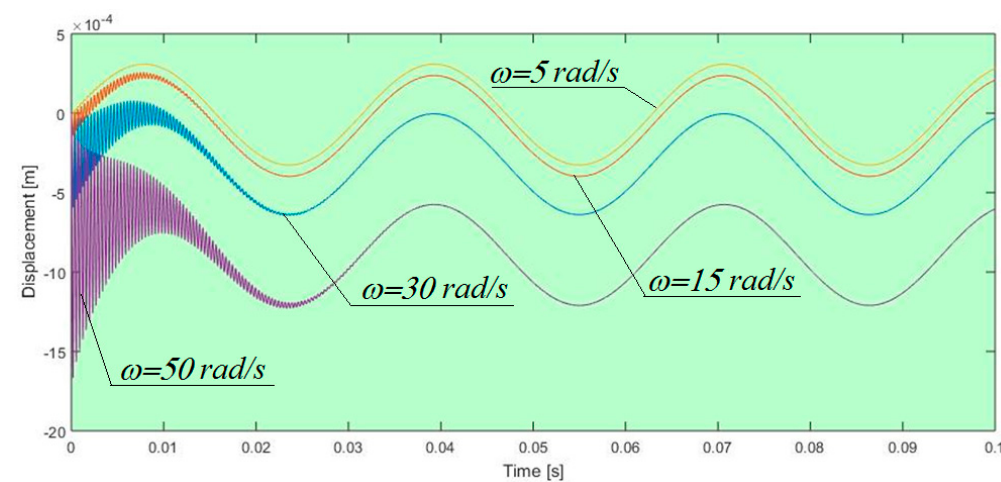
Figure 12. Cross-section area A = 0.00006 m 2 . Varying the excitation frequency, we obtain the results presented in Figure